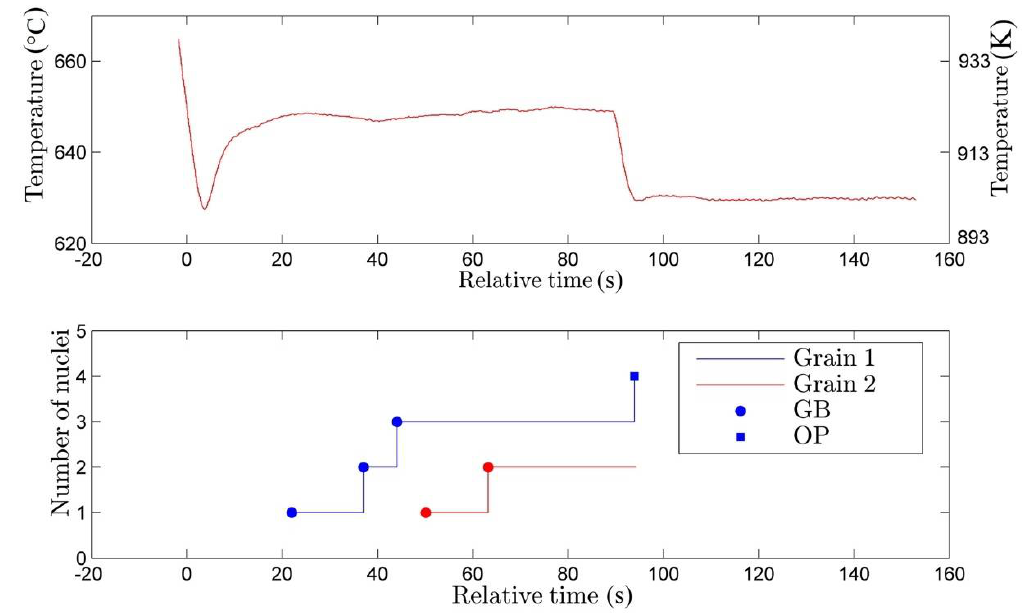
Figure 6. Temperature and nucleation sequence versus time of bainitic ferrite plates in Fe-0.2C-1.5Mn-2.0Cr during isothermal holding treatment at 923 K (650 °C).